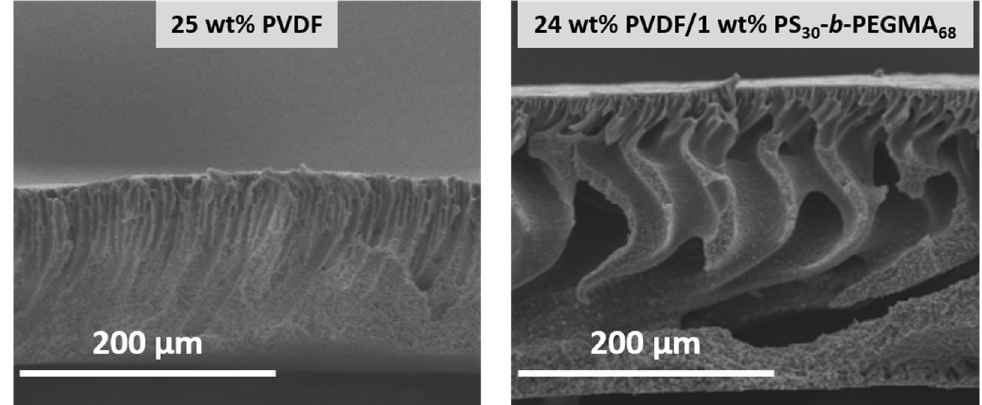
Figure 5. Influence of the addition of 1 wt% PS 30 - b -PEGMA 68 copolymer to a casting solution containing PVDF (NMP as solvent) on the cross-sectional morphology of LIPS membranes (T dissolution : 40 °C; Solvent content fixed: 75 wt%; non-solvent: DI water; casting thickness: 300 µm). Left image partially reproduced with permission from [357]. Copyright 2014 Elsevier.